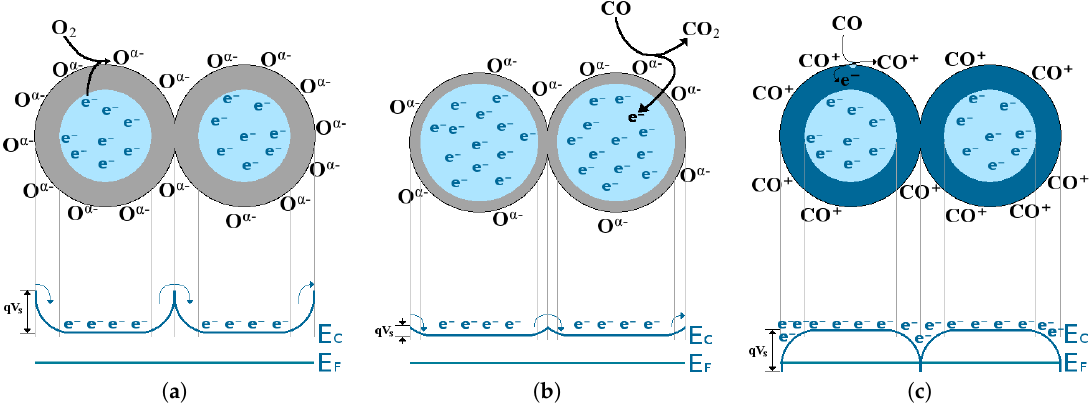
Figure 18. Gas sensing and resulting band bending for a granular film. ( a ) O α − adsorbs on the surface, creating a depletion region and band bending, ( b ) CO reacts with oxygen, thinning the depletion region and reducing band bending, and ( c ) CO adsorbs directly on the surface, creating an accumulation region and band